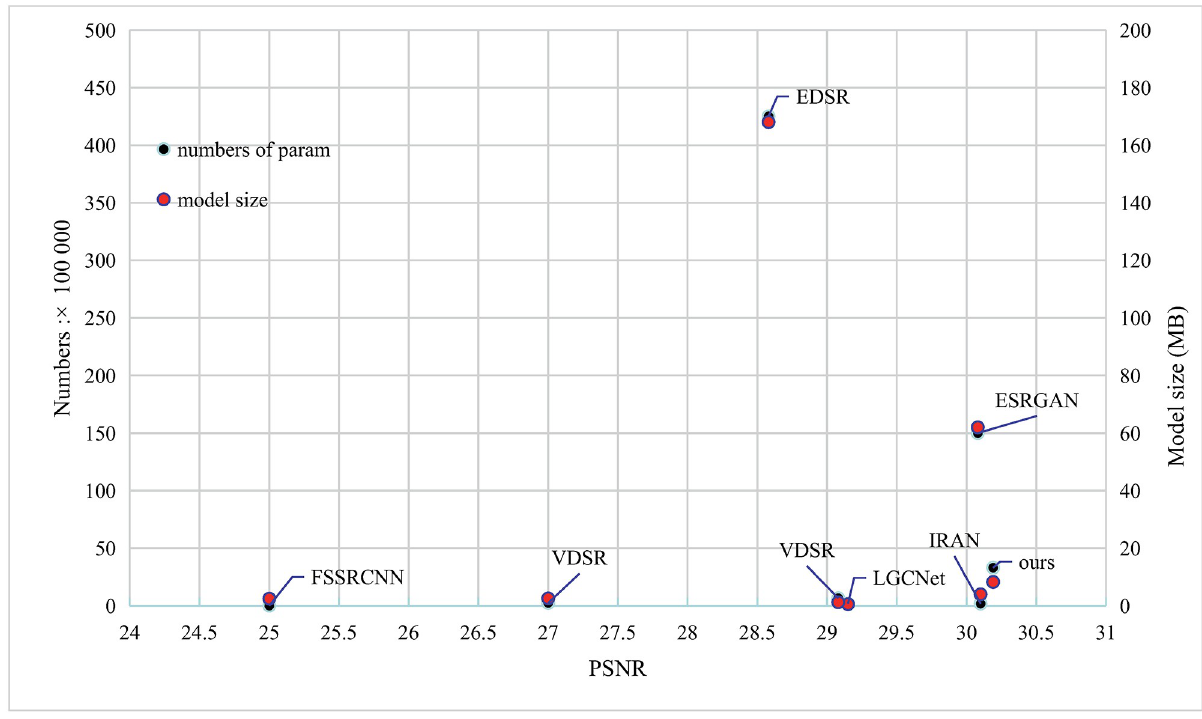
Fig 7. Comparison between model complexity and image quality. The left vertical axis is the number of parameters, and the right vertical axis is the size of the model file.